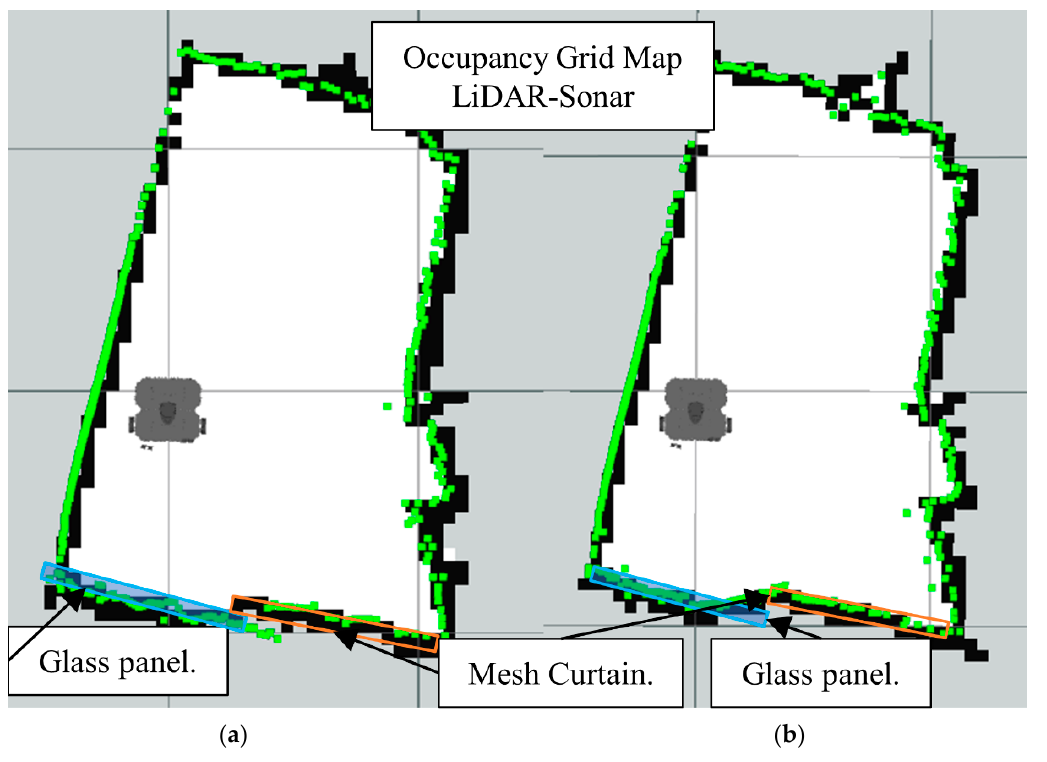
Figure 27. Occupancy grid maps showing the: ( a ) Ground truth (reference map); ( b ) LiDAR-Sonar fusion generated map with glass panel.